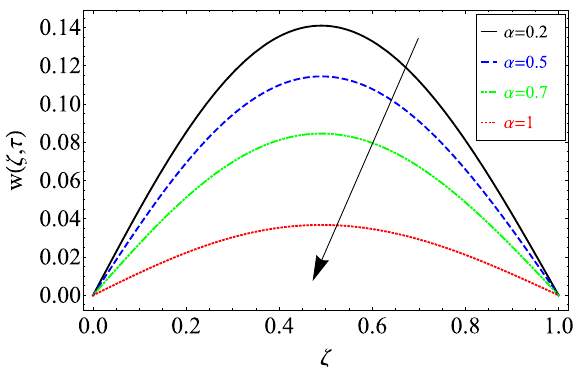
Figure 2. The effect of different values of α on velocity distribution of Maxwell nanofluid, when Re = 10 , τ = 0.5 , φ = 0.02 , Gr = 0.05, Gm = 0.5, Pr = 6300, Sc = 15 and (cid:31) = 0.5 .